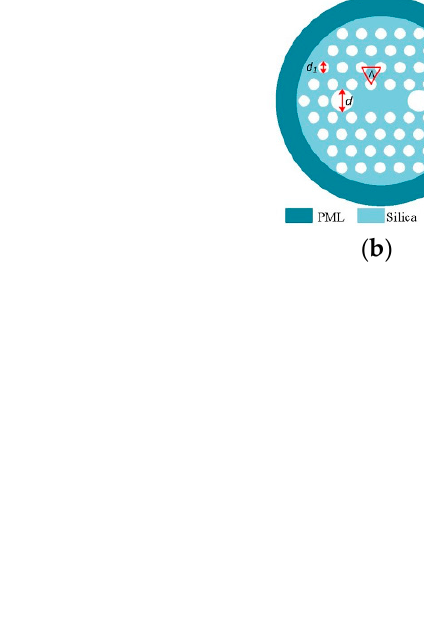
Figure 7. ( a ) Schematic diagram of the PM-PCF SI salinity measurement with the output spectrum of the sensor probe [65]. ( b ) The proposed seawater − filled PCF [67]. ( c ) Schematic diagram of the performance test system for the proposed SI based on concatenated panda PMF tapers [68]. Reprinted with permission from Ref. [68] © The Optical Society. Table 4. Summary of